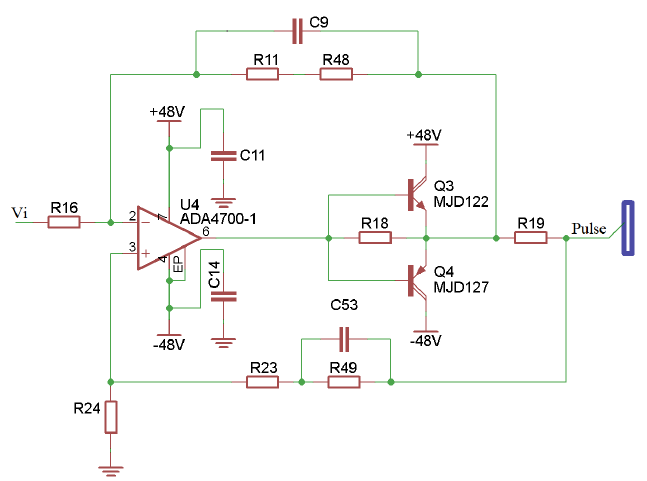
Figure 4. Modified Howland current source